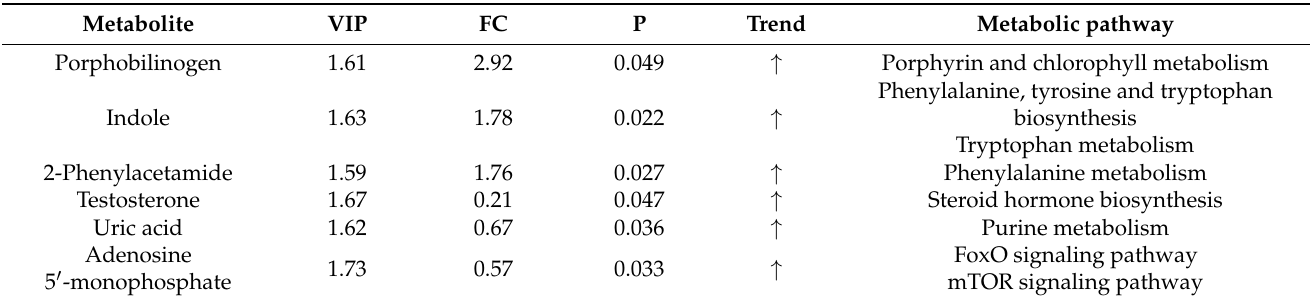
Table 2. Metabolites which were significantly differentially abundant in the gills of Takifugu obscurus under hypoxic stress and the associated metabolic